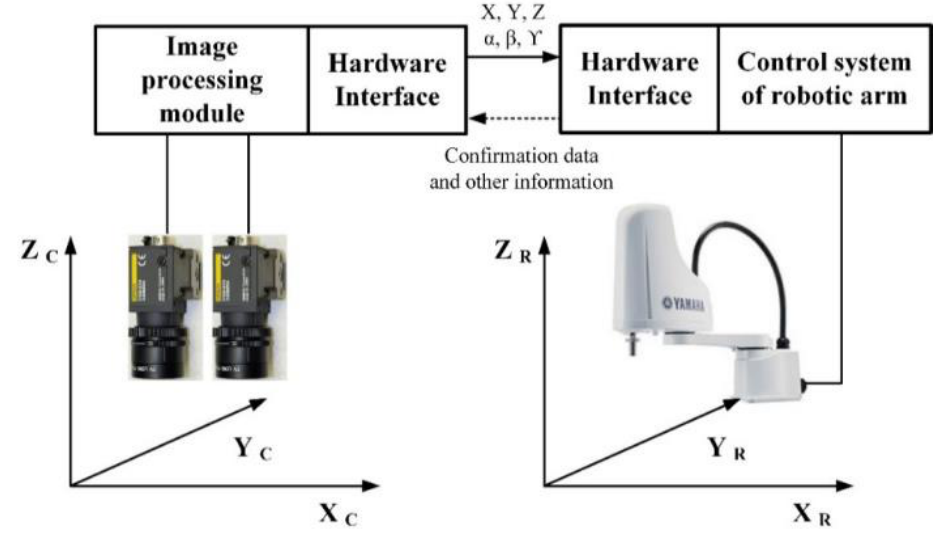
Figure 2. Composition of the sensing principle.